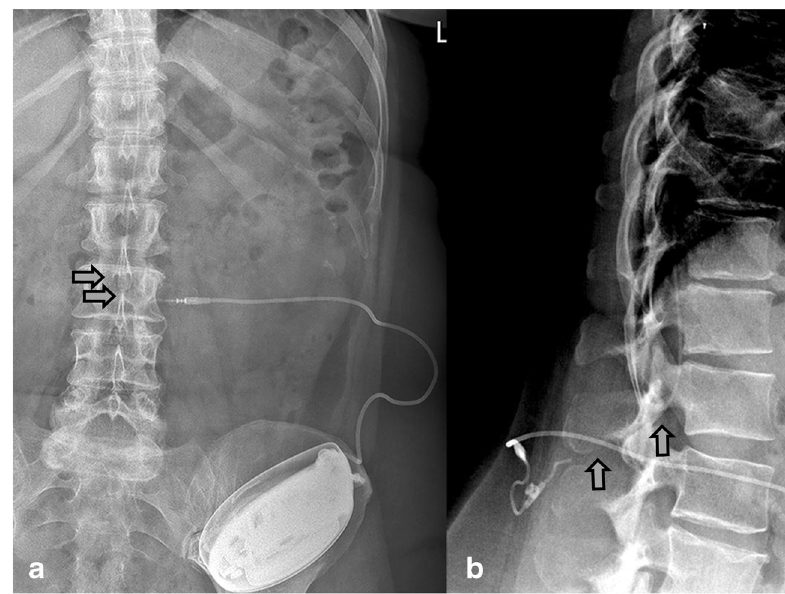
Fig.10 Shearedcatheter 8731SC ( gray arrow ) with retracted segment partially outside the spinal canal, with no cerebrospinal leakage and no clinical signs of postural spinal headache or an intracranial hypotension syndrome, in a 48-